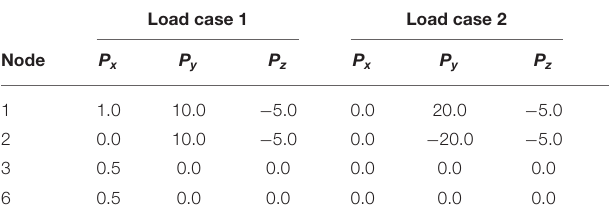
TABLE 2 | 25-bar space truss: Load cases (loads in kips).